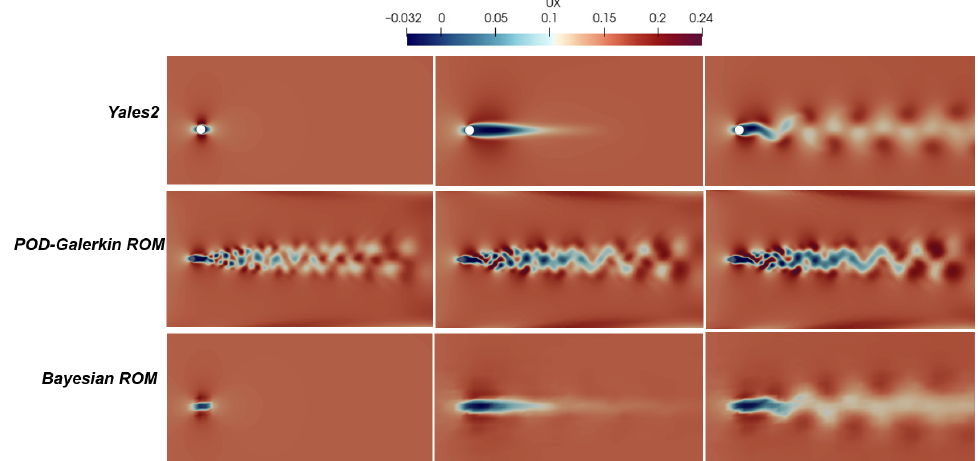
Figure 10. mesh n°1: On the top, the high-fidelity horizontal velocity fields in m/s by the solver Yales2. In the middle, the POD-Galerkin horizontal velocity fields in m/s. On the bottom, the horizontal velocity fields in m/s by the mean prediction of the Bayesian nonlinear